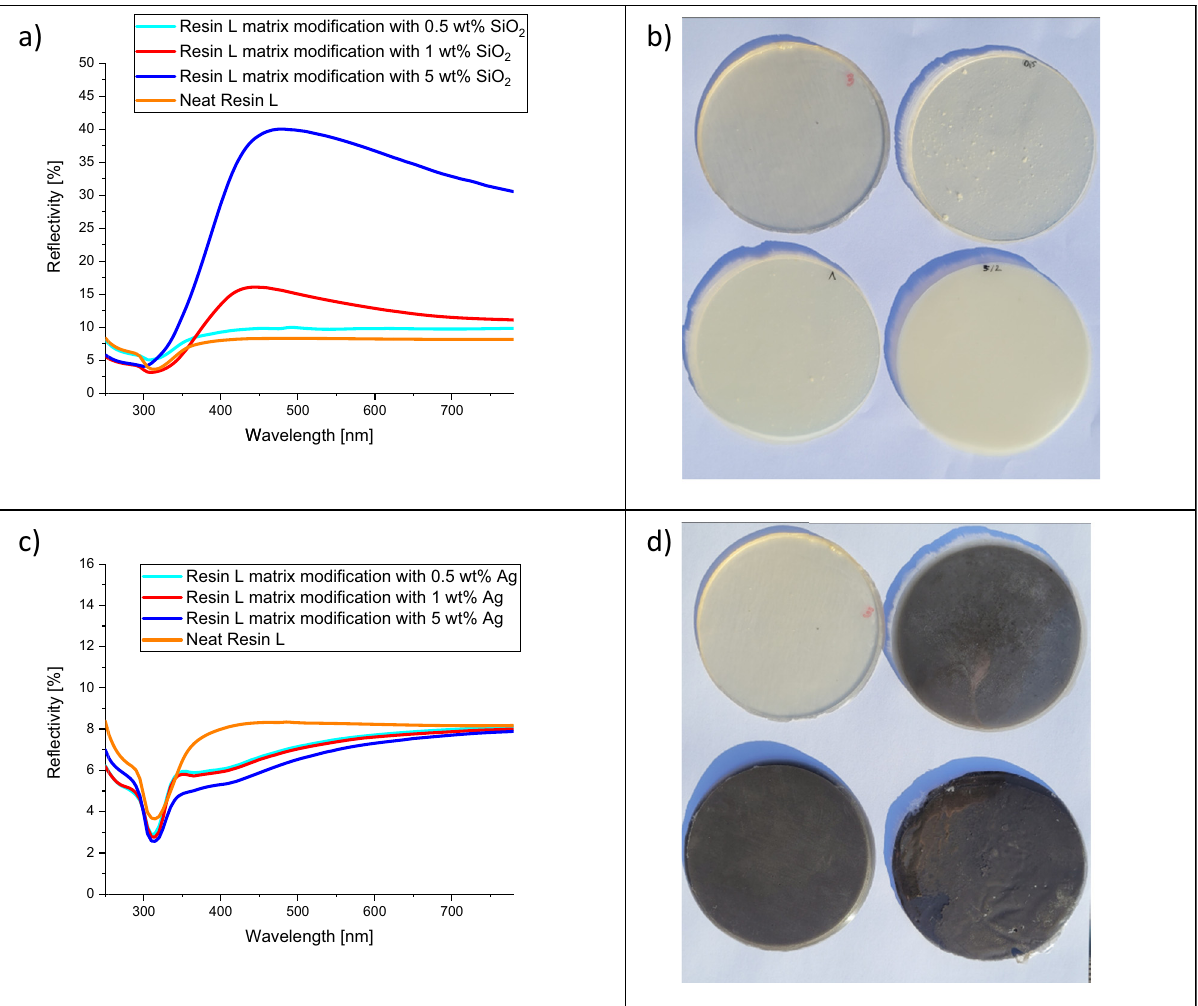
Figure 8: Comparison of UV/VIS re fl ectivity measurement results of neat Resin L and nanoparticle - modifed samples using di ff erent ( a ) SiO 2 and ( c ) Ag nanoparticle contents and visual appearance ( photographs ) of neat and modi fi ed Resin L samples with increasing ( b ) SiO 2 and ( d ) Ag nanoparticle content ( neat resin L sample in upper left corner, 0.5 wt% nanoparticles in upper right corner, 1 wt% nanoparticles in lower left corner, and 5 wt% nanoparticles in lower right corner ) . The samples have a diameter of 9 cm and a thickness of 3